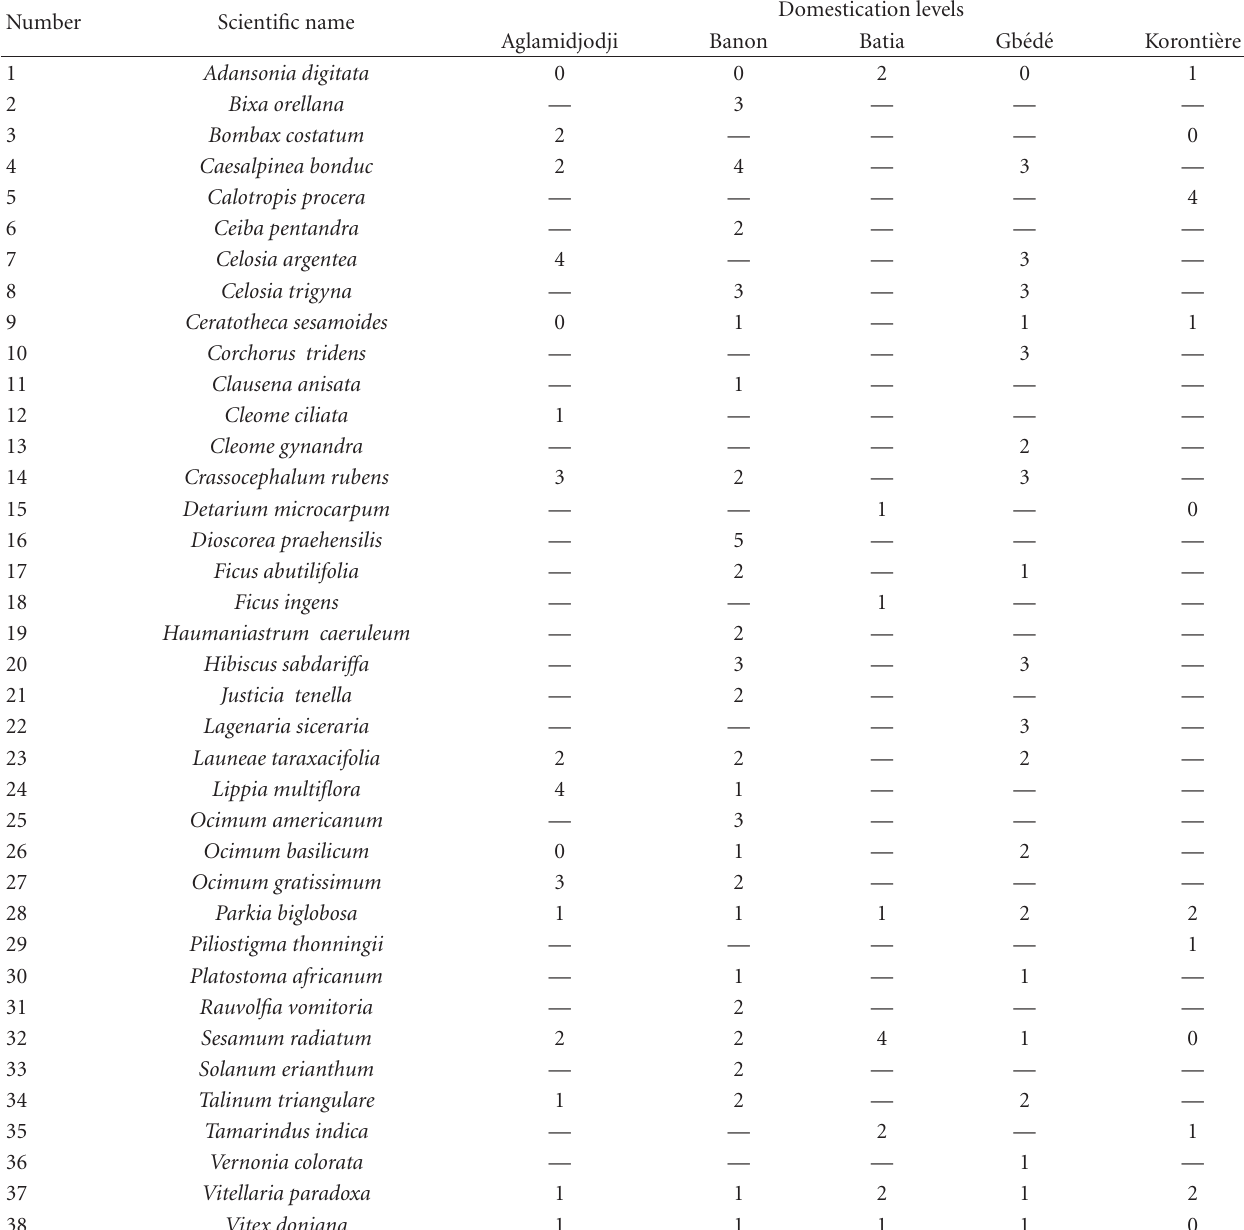
Table 4: Domestication levels of the species and their variations across villages (species found only at Step 1 are not included).